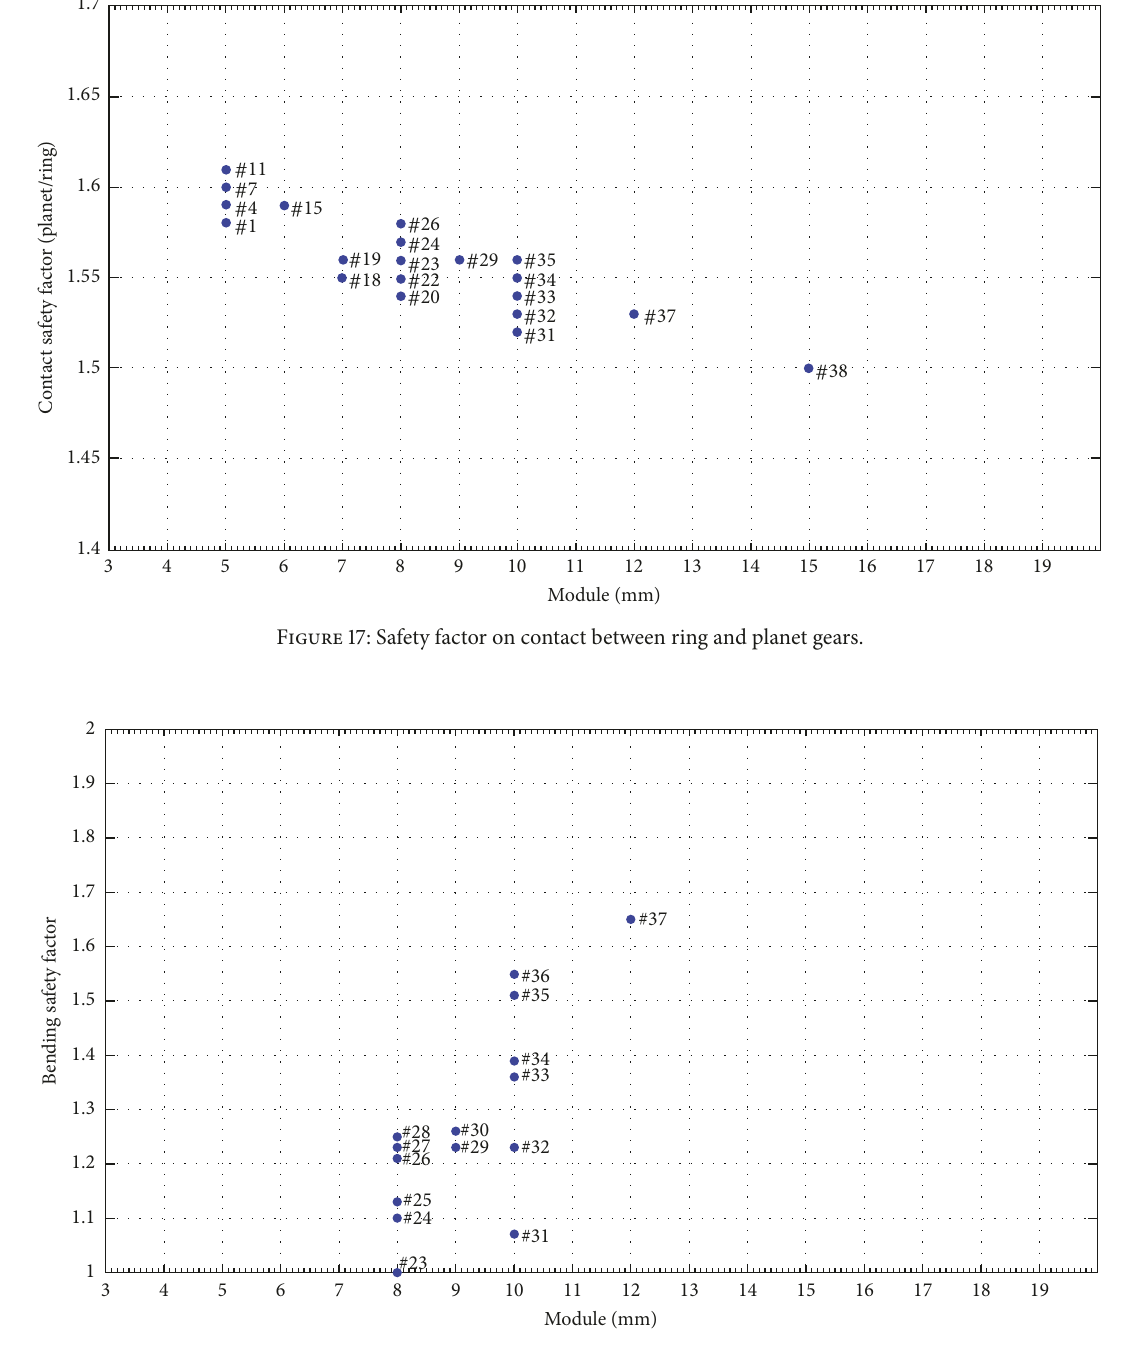
Figure 18: Minimum safety factor on bending at